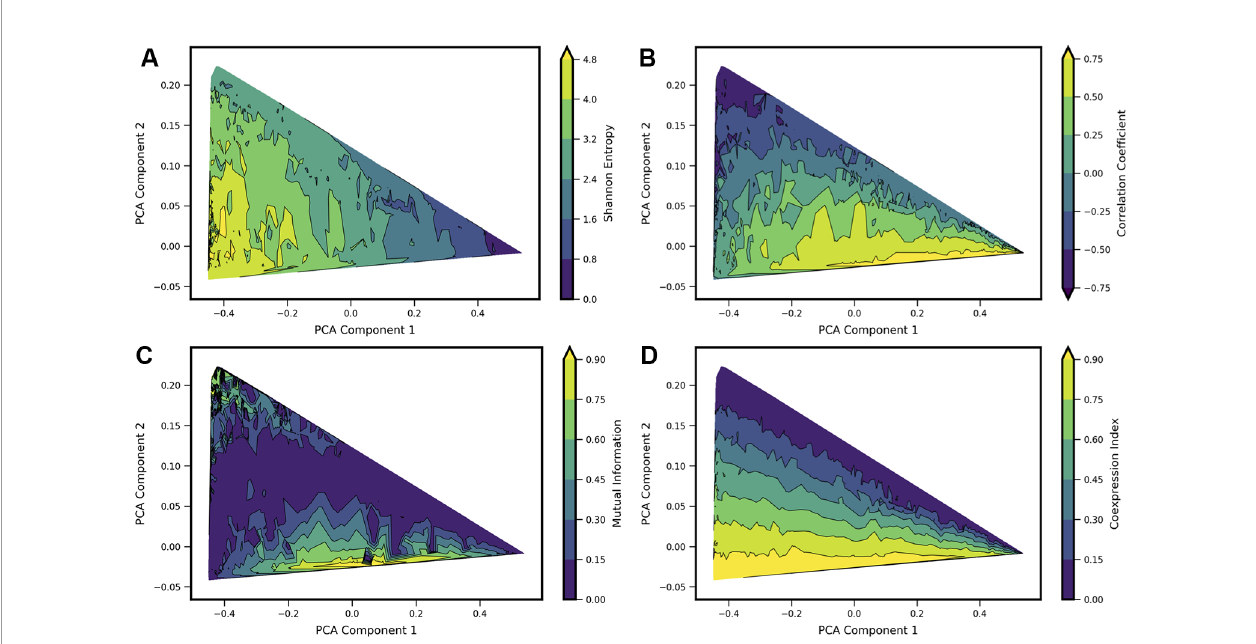
FIGURE 4 | Comparisonoffourstandard metrics ofgene-gene coexpression with landscapeshape. Metrics include: (A) ShannonEntropy. (B) Correlation Coef fi cient. (C) MutualInformation. (D) Coexpression Index (see text for details). Each metric was computedfor each computed model landscape, usingthe same set of 34,097 Two-Gene Flex modelsas in Figures2 and 3 . Contour plots show each metric as a function ofprincipalcomponents 1 and2, obtained bylocal averagingandinterpolation over the results fromindividual model landscapes. Taken together with Figure 2 , the results show how these metrics correspondwith landscape